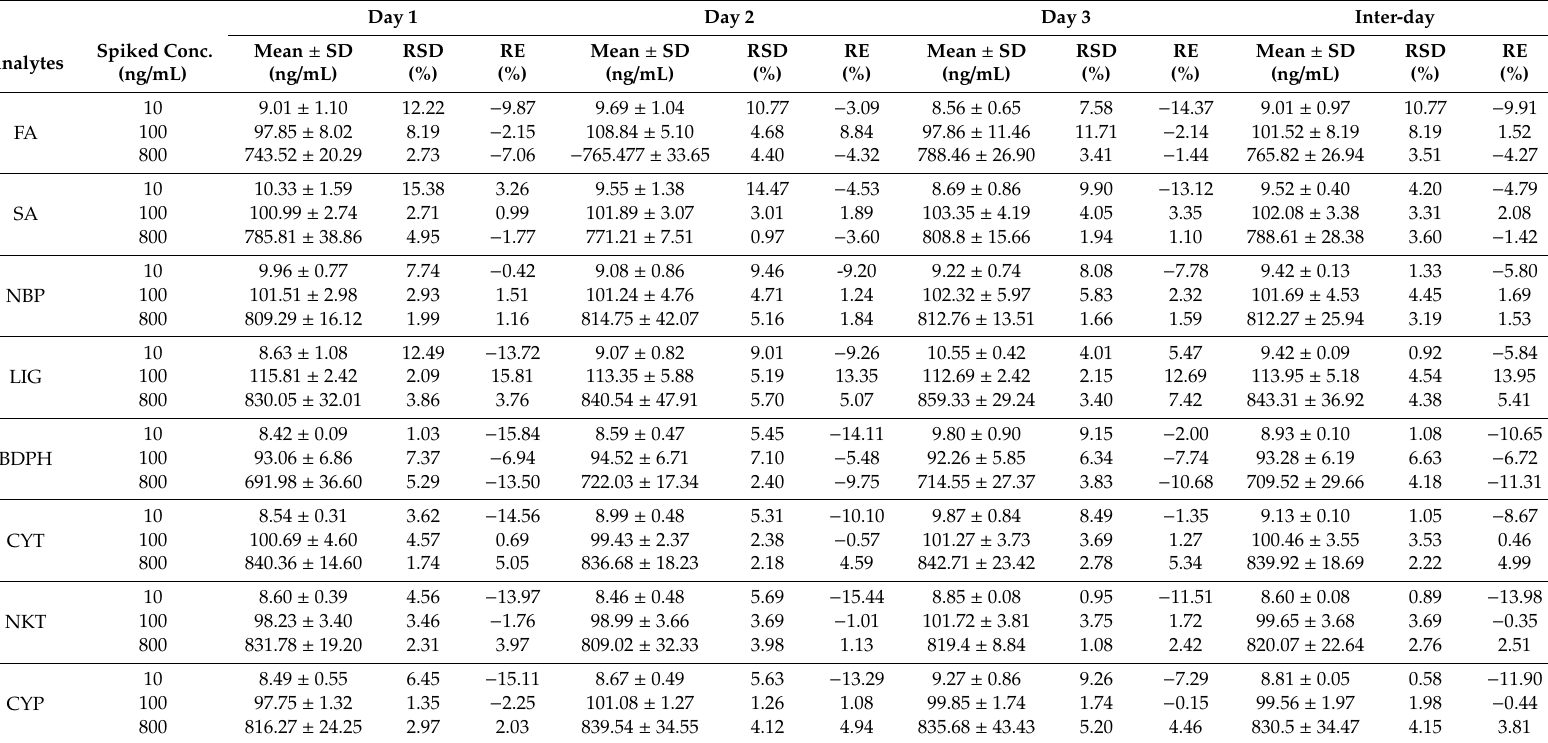
Table 1. Intra-and inter-day precisions and accuracies of the analytes in rat serum ( n =